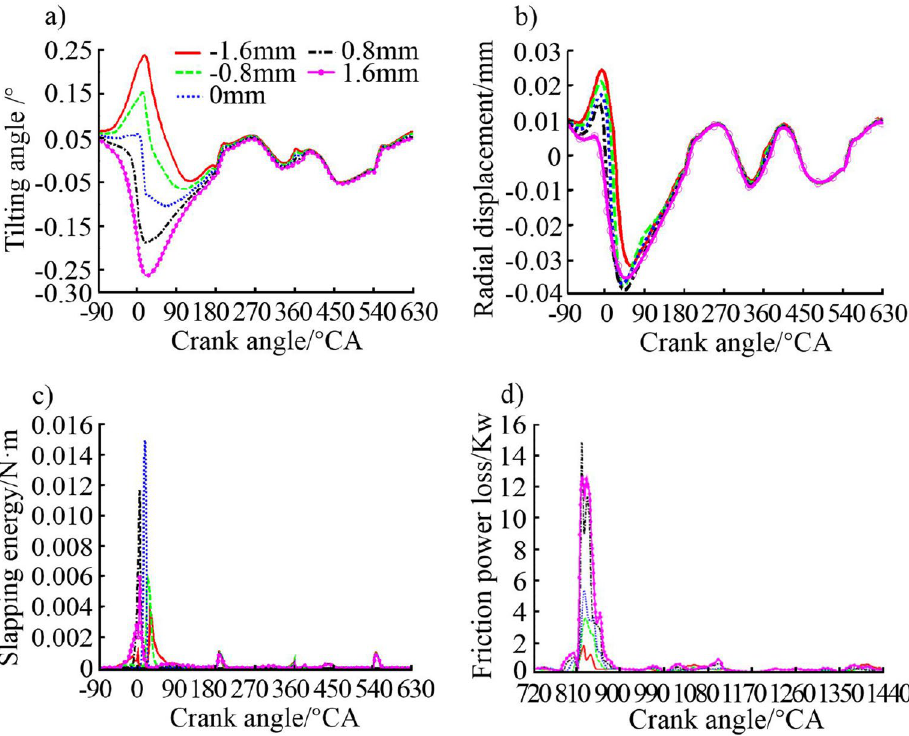
Figure 10. Effect of piston pinhole offset on ( a ) piston tilting angle, ( b ) piston radial displacement, ( c ) piston slapping energy, and ( d ) piston friction power loss.